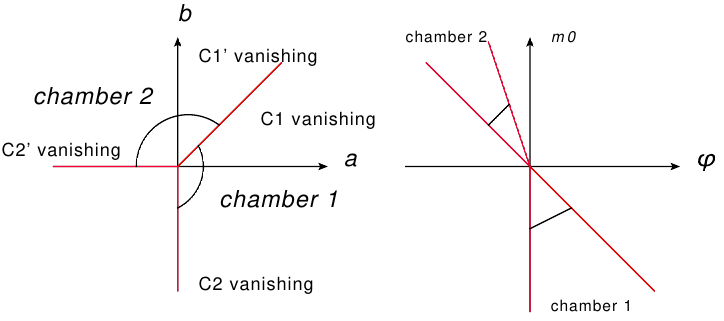
Figure 9 . The Nef fan for the toric diagram C in figure 5, see figure 8 for the resolutions and notation for the curves.